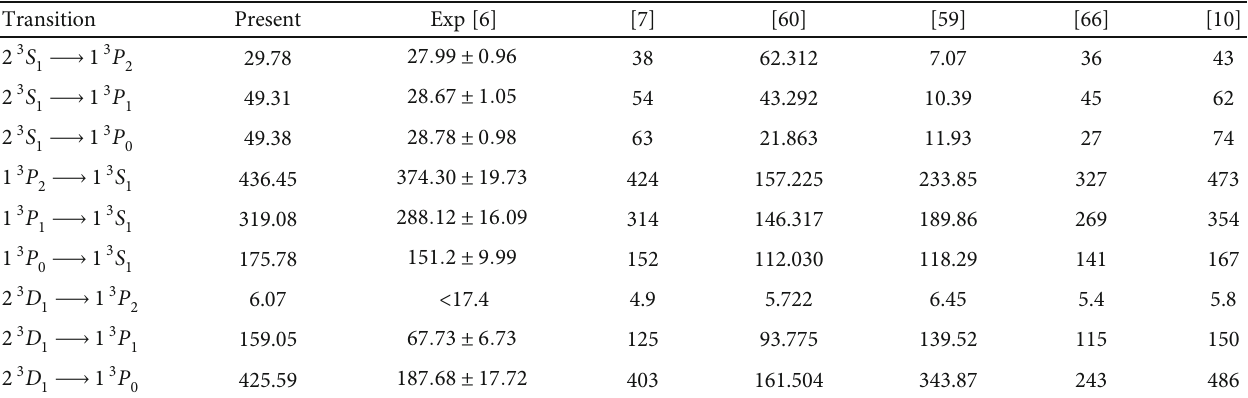
Table 6: E 1 radiative partial widths (in